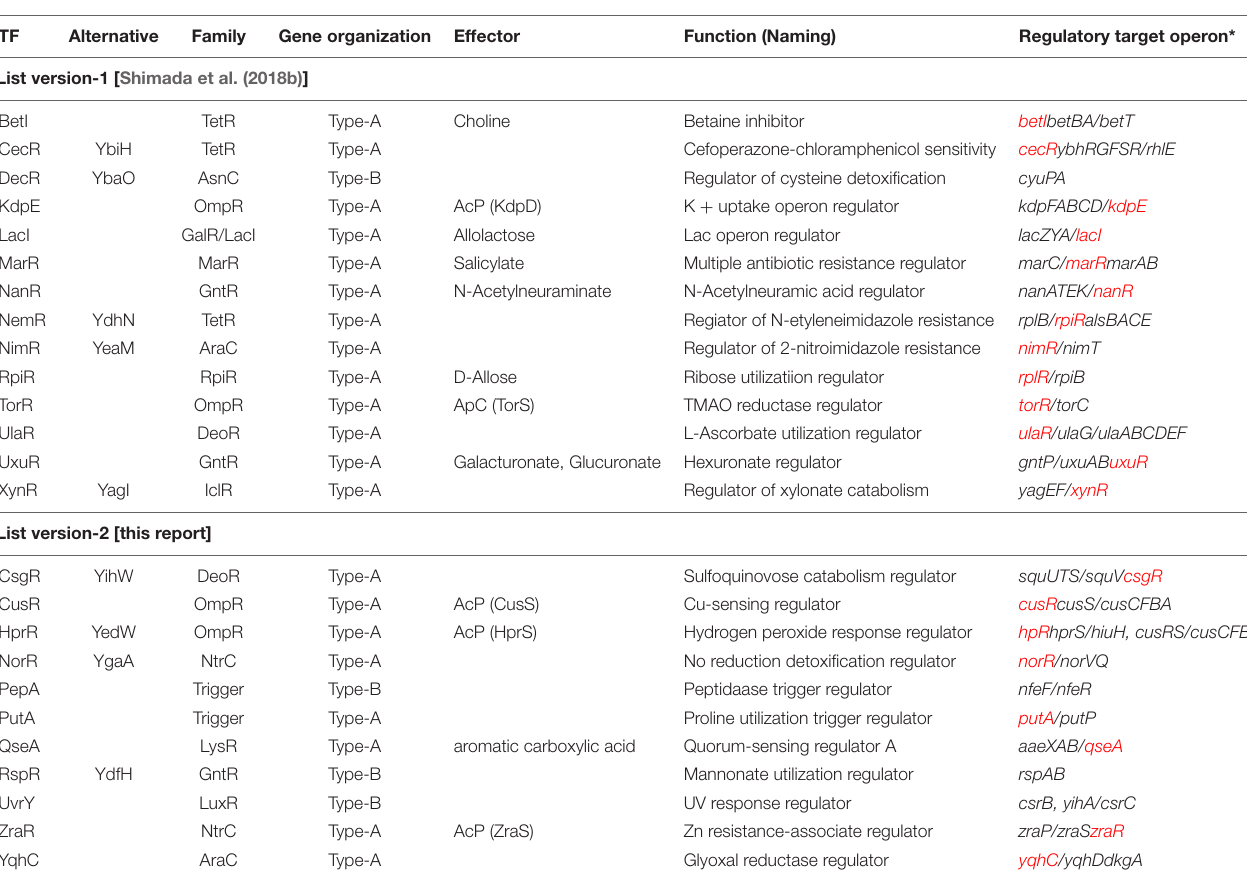
Frontiers in Microbiology |